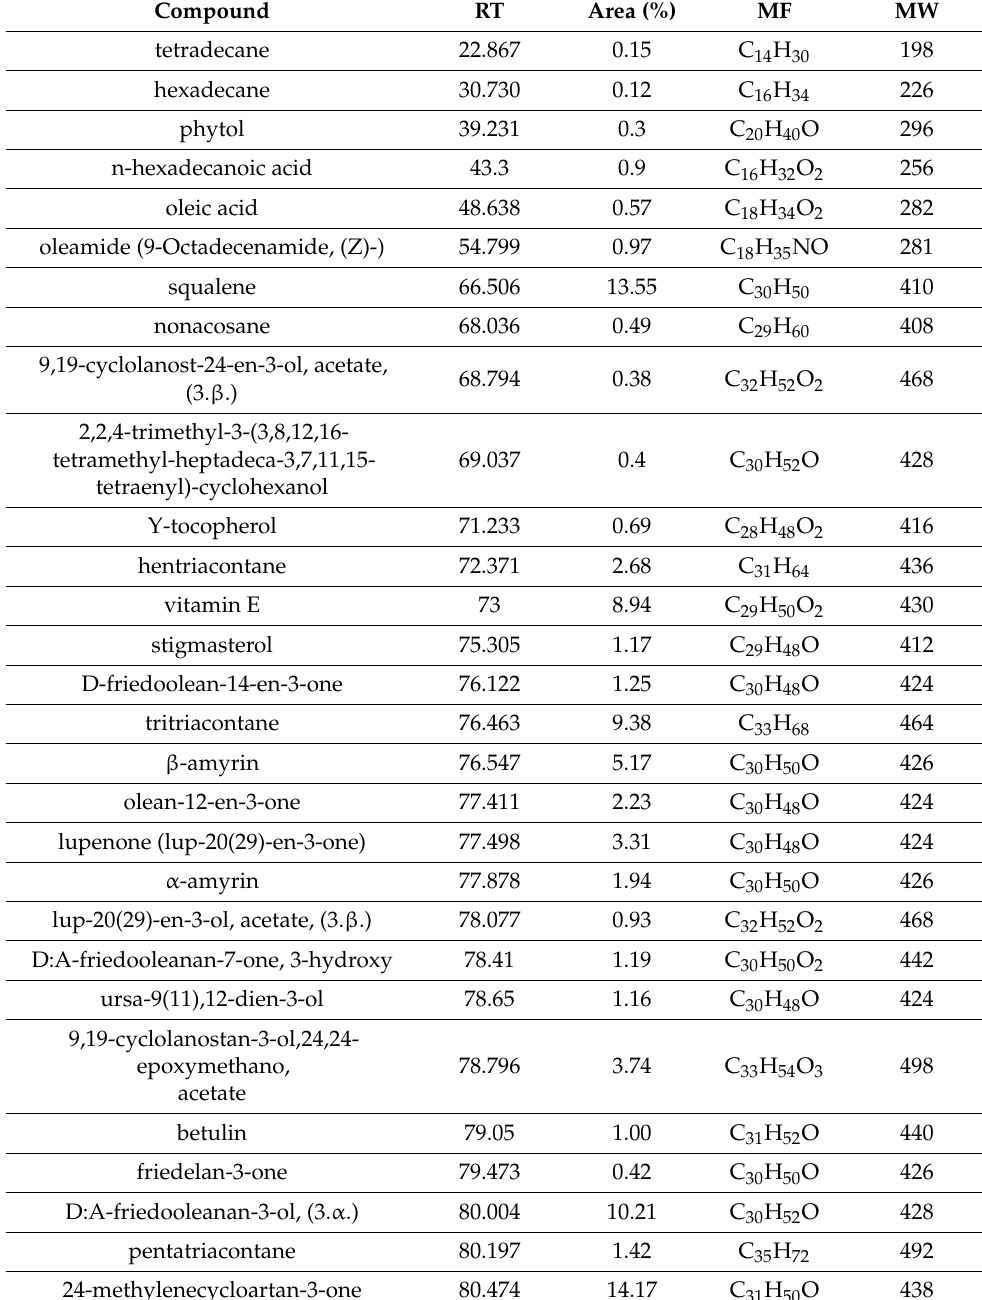
Table 3. Proposed phytochemical constituents in ACH extract compared with the National Institute of Standards and Technology (NIST)